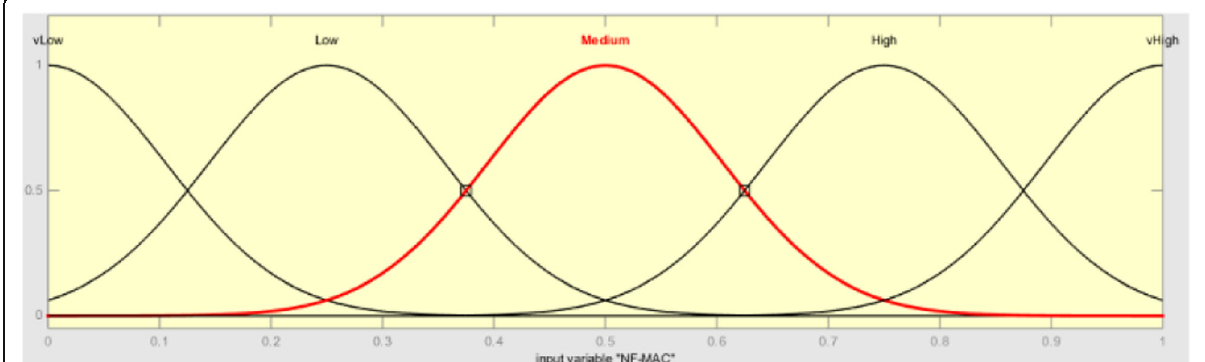
Fig. 4 Third input variable “ Normalized Machine Frequency